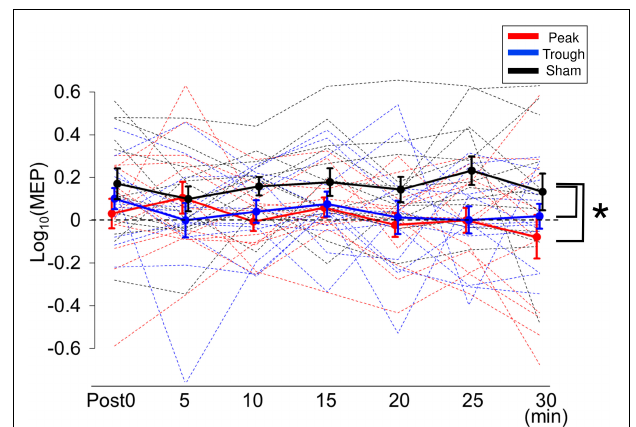
FIGURE 4 | Mean MEP amplitudes after iTBS/ β -tACS. MEP amplitudes were processed in the same manner as that described in Figure 3 . MEP amplitudes for the sham condition were clearly enhanced after the intervention, whereas those for the peak and trough conditions were not significantly modulated. Consequently, MEP amplitudes for the peak and trough conditions were lower than those for the sham condition. Error bars indicate SEM. * p <